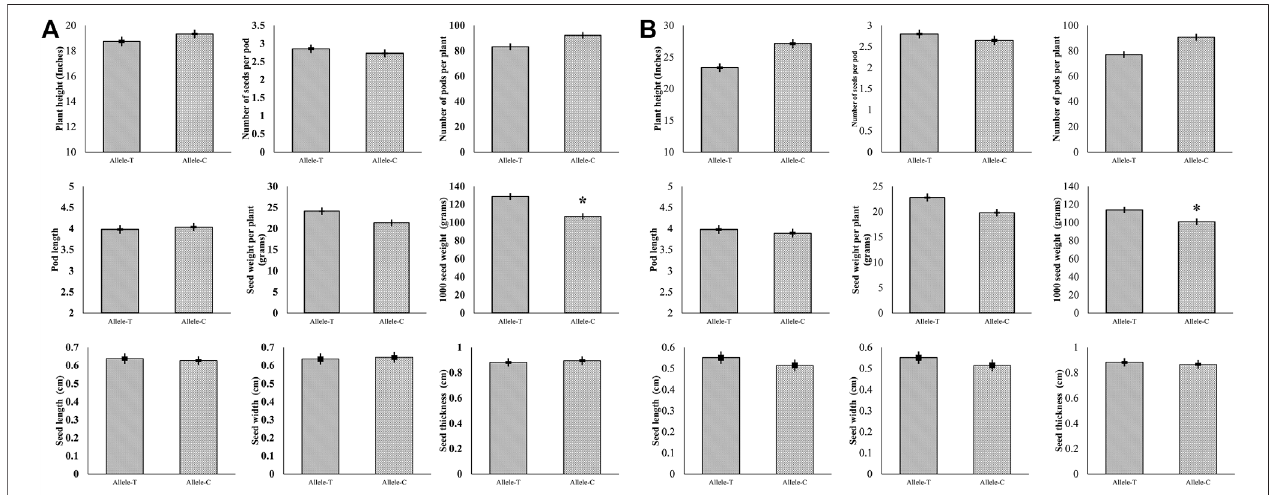
FIGURE 8 | Phenotypic comparison of two GmHH3-3 allelic variations in two environments. (A) Phenotypic comparison under well-watered and (B) under water- limited conditions.